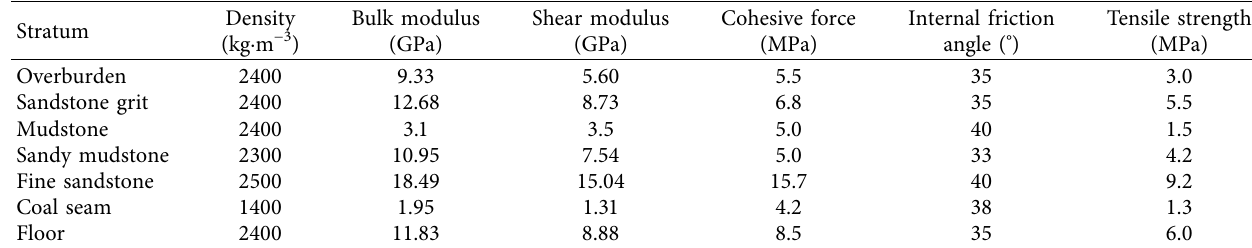
Figure 1: Numerical simulation model. Table 1: Physical and mechanical parameters of various